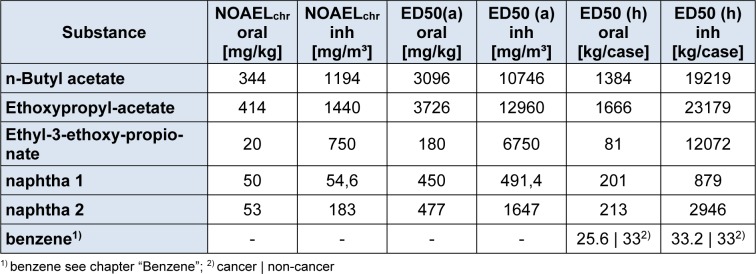
ED50 values of the solvents